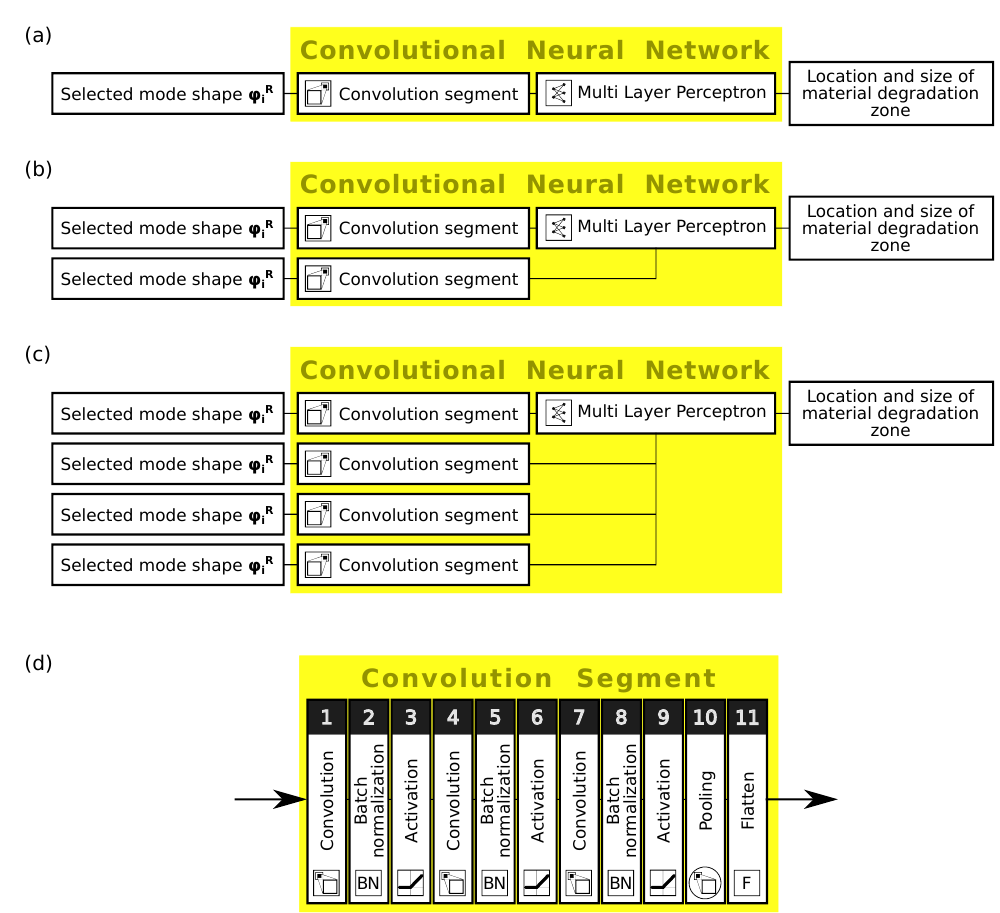
Figure 2. The scheme of CNN applied for the identification of material degradation zone: ( a ) one mode shape as input, ( b ) two mode shapes, ( c ) four mode shapes, and ( d ) convolution